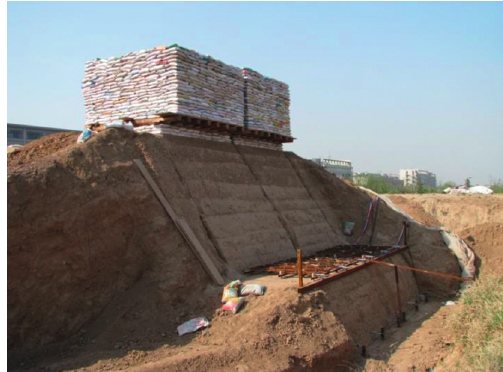
Figure 8: Multi-stage loading on the top of the landslide model.